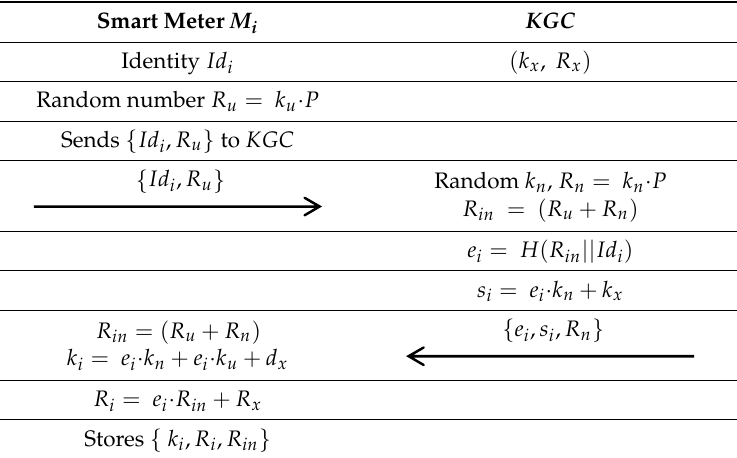
Table 8. Request and authentication phase of the proposed scheme.